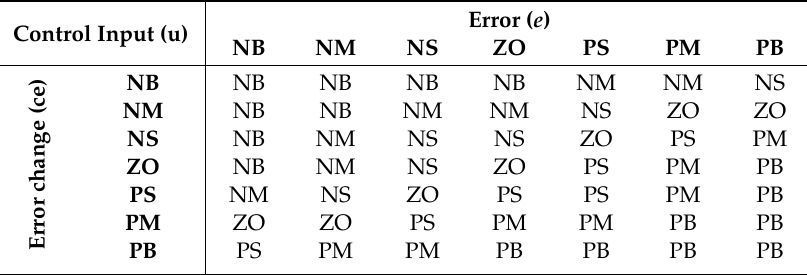
Table 3. Fuzzy control